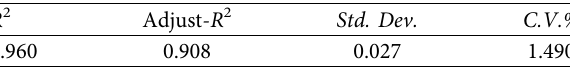
Table 2: Model fit statistic of MOE.